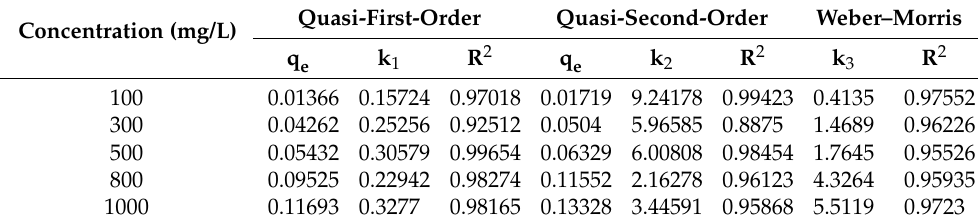
Figure 8. The curve of the electrosorption capacity with time to the power of 0.5 under different concentrations. Table 2. Dynamic equation fitting results.